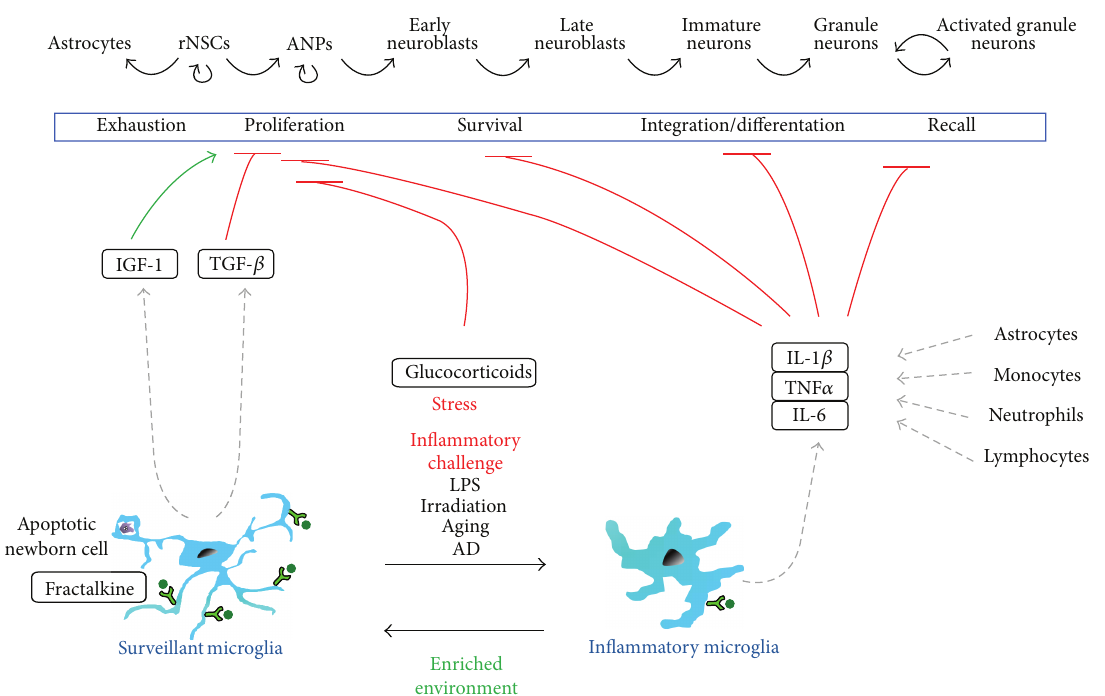
Figure 1: The effects of surveillant and inflammatory microglia on the adult hippocampal neurogenic cascade. During physiological conditions, surveillant microglia effectively phagocytose the excess of apoptotic newborn cells and may release antineurogenic factors such as TGF 𝛽 . This anti-inflammatory state is maintained by neuronal (tethered or released) fractalkine. Enriched environment drives microglia towards a phenotype supportive of neurogenesis, via the production of IGF-1. In contrast, inflammatory challenge triggered by LPS, irradiation, aging, or AD induces the production of proinflammatory cytokines such as IL-1 𝛽 , TNF 𝛼 , and IL-6 by microglia as well as resident astrocytes and infiltrating monocytes, neutrophils, and lymphocytes. These cytokines have profound detrimental effects on adult neurogenesis by reducing the proliferation, survival, integration, and differentiation of the newborn neurons and decreasing their recall during learning and memory